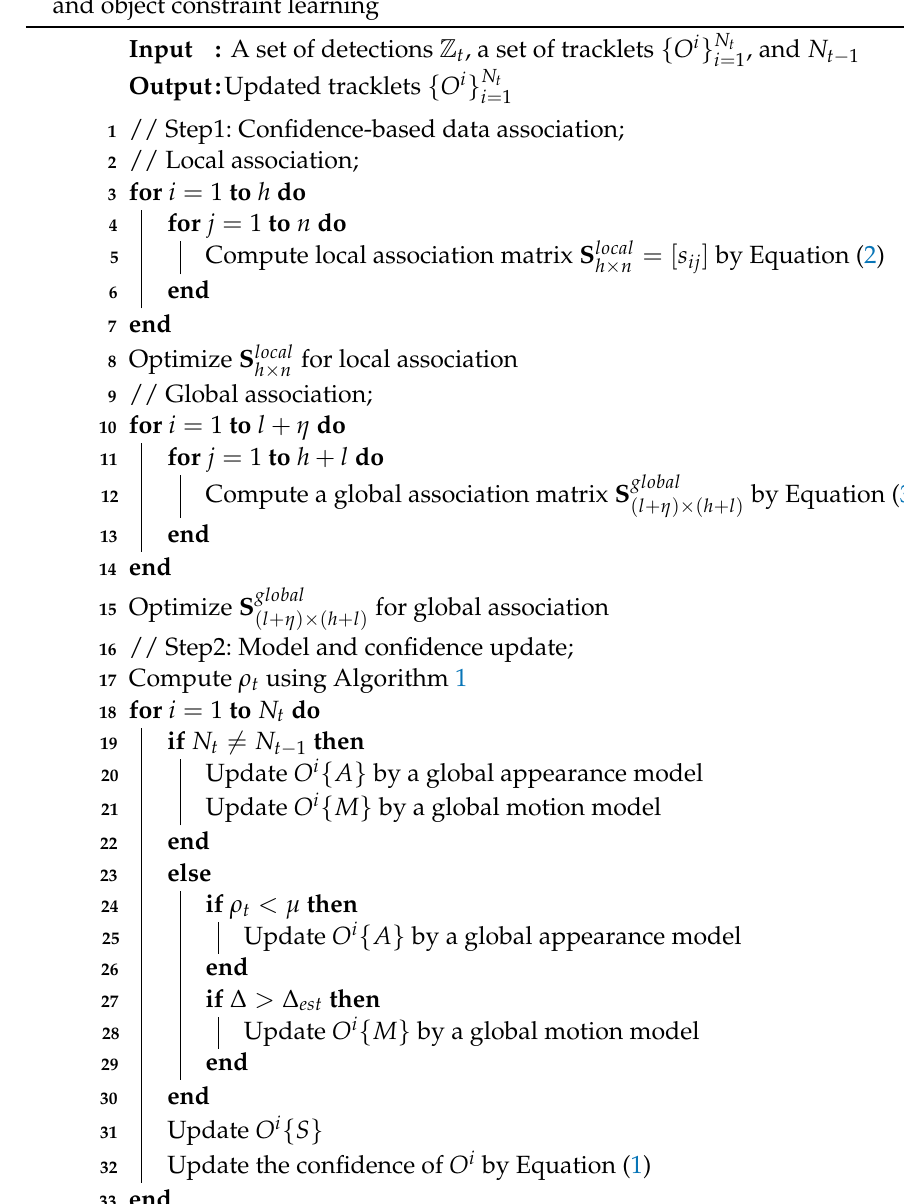
Algorithm 2: The overall MOT algorithm with the proposed global models and object constraint